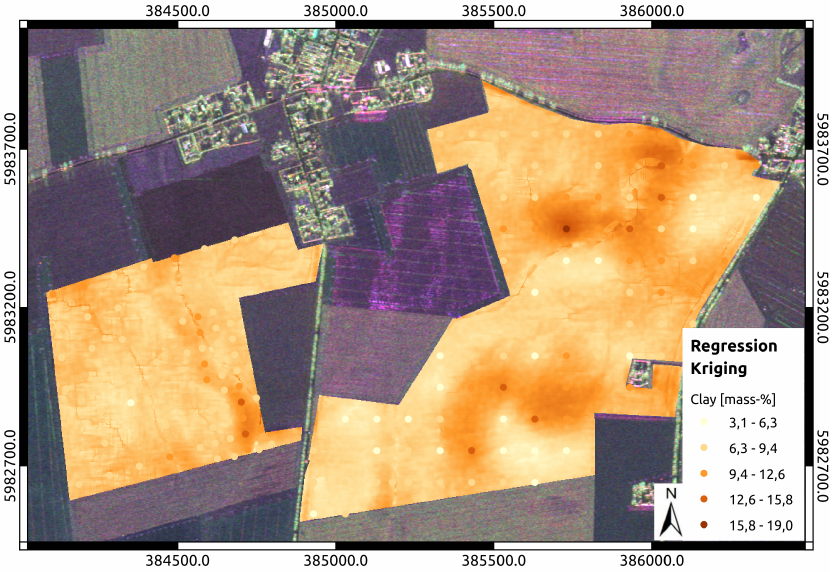
Figure 9. Spatial interpolated soil map for the texture class silt based on the RK approach. Circles display the sample locations and colors are scaled in the same color as background silt map.